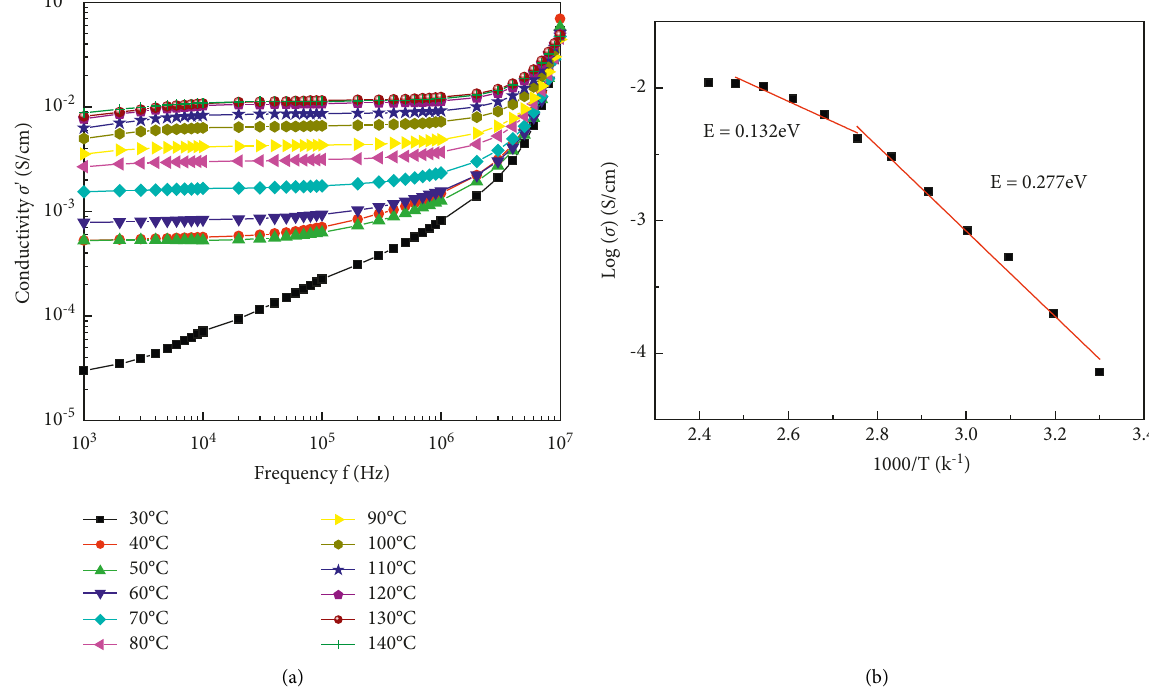
Figure 13 (a) Frequency dependence of AC conductivity at different temperatures. (b) log( · ) versus 1000/T, for 1 wt.% FeCl2 PVA/PVP electrolyte